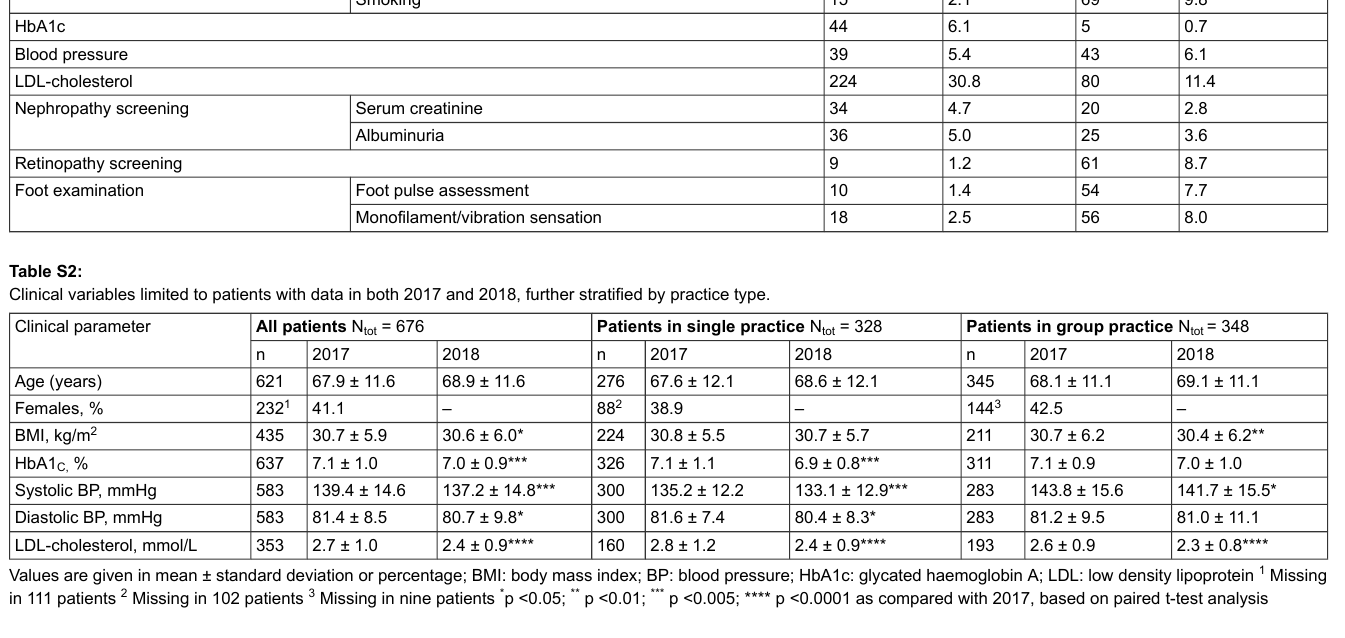
Table S3: Therapy modalities and nicotine abuse limited to patients with data in both 2017 and 2018, further stratified by practice type. All patients N tot =